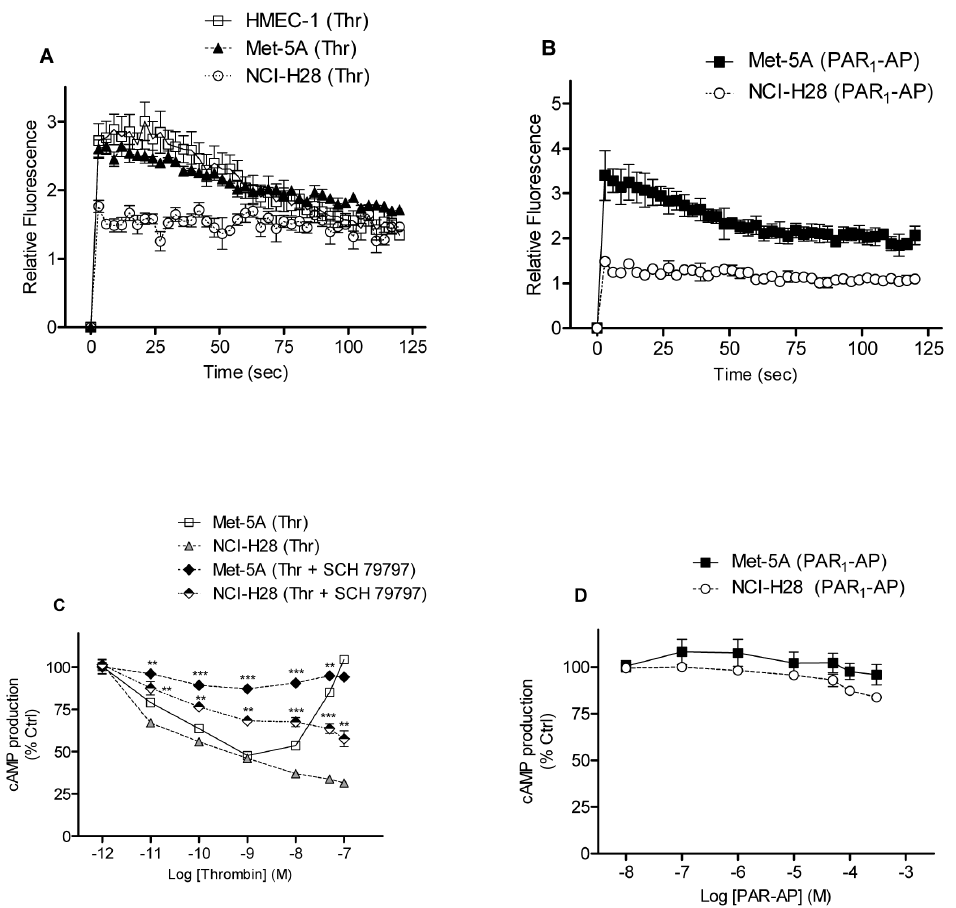
Figure 4. PAR 1 agonist-induced G q but not G i signaling is impaired in NCI-H28 cells. A, thrombin-induced intracellular Ca 2 + mobilization in HMEC-1, Met-5A, and NCI-H28 cells. B, selective-PAR1-AP-induced intracellular Ca 2 + mobilization in Met-5A and NCI-H28 cells. Serum and growth factor starved cells were loaded with Fluo-3AM to measure [Ca 2 + ] i variations as indicated by changes in fluorescence intensity. Fluorescence was recorded before agonist addition (F 0 ) and then every 3 seconds after thrombin (10 nM) or PAR 1 -AP (10 m M) addition for another 120 seconds. Data shown are mean 6 SEM of a single experiment done in triplicate. Experiments were repeated two additional times with similar results. The results are reported as relative fluorescence (RF=F/F 0 where F 0 is basal fluorescence and F is fluorescence recorded after cell stimulation with the agonist). C, inhibition of isoproterenol stimulated cAMP production in Met-5A and NCI-H28 cells by different concentrations of thrombin in the presence and absence of 100 nM SCH 79797. D, no effect of the selective PAR 1 -AP on isoproterenol stimulated cAMP production in Met-5A and NCI-H28 cells. Serum and growth factor starved cells were exposed to different agonist concentrations. Assays were initiated by the addition of 1 m M isoproterenol. Production of cAMP was measured using a competition binding assay which includes the bovine adrenal cAMP binding protein and [ 3 H]cAMP. Data shown are mean 6 SEM of three independent experiments performed in triplicate. The differences between thrombin- and thrombin plus SCH 79797-treated cells were significant (**P # 0.01, ***P # 0.001) by one-way ANOVA followed by Bonferroni’s multiple comparison test